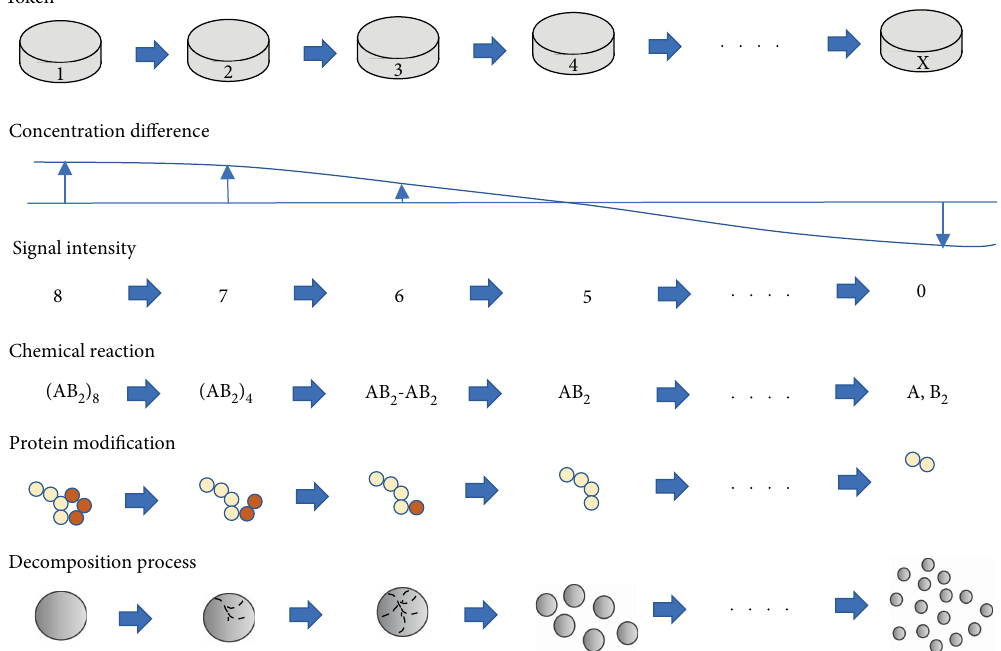
Figure 3: Tokens labeled with integer values describe various processes. If the integer labels represent concentration differences, this is equivalent to the conventional model of two diffusive chemicals. If the integer labels represent signal levels, this is equivalent to the pseudopodium– nerve model. Therefore, this basic model can be applied to various processes, such as concentration differences, signaling, chemical aging, and protein